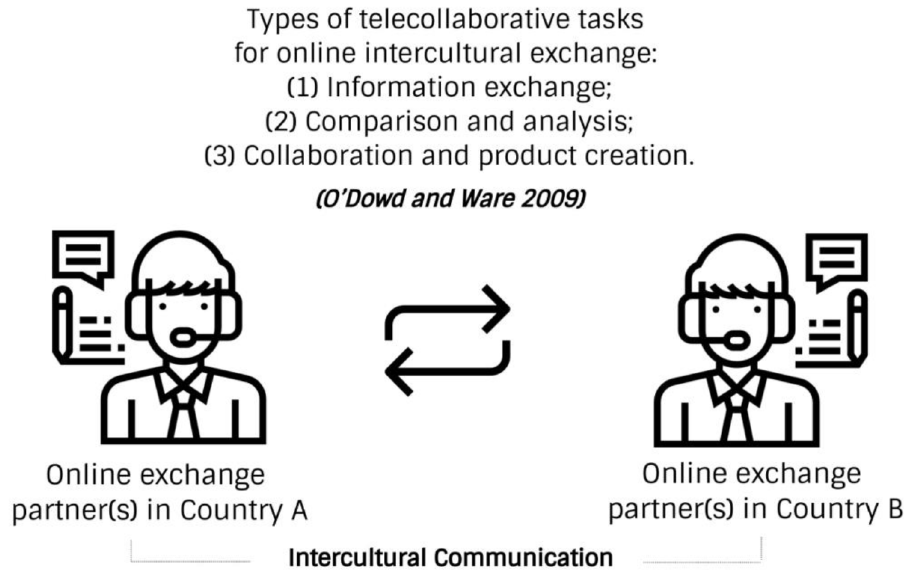
Figure 1. Conventional online exchange and telecollaborative